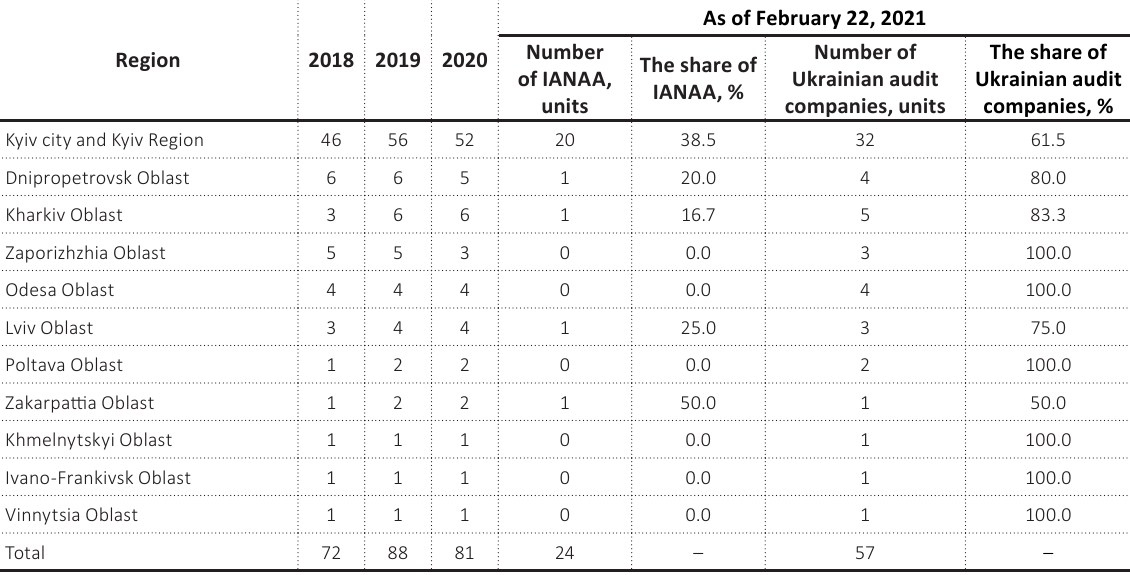
Table 3. IANAA in the bank audit market as public interest